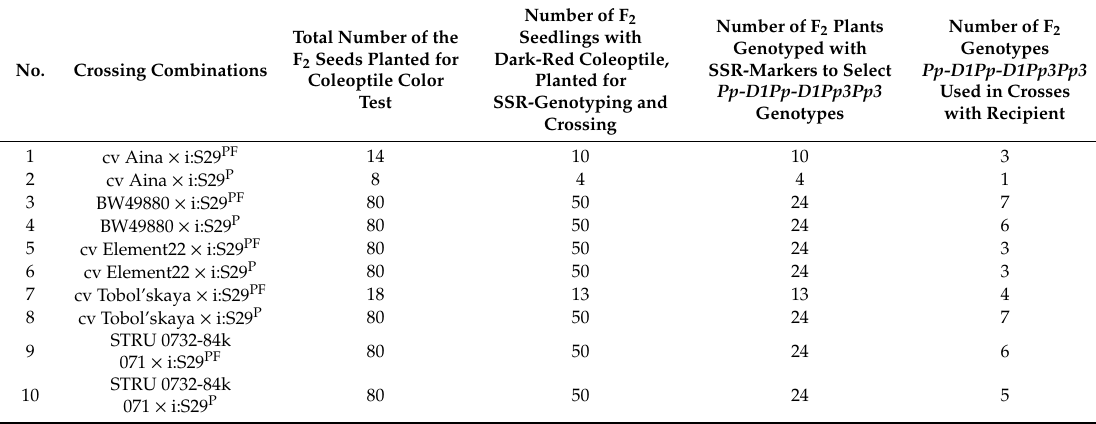
Table 3. The crosses and number of plants obtained and assessed during MAS